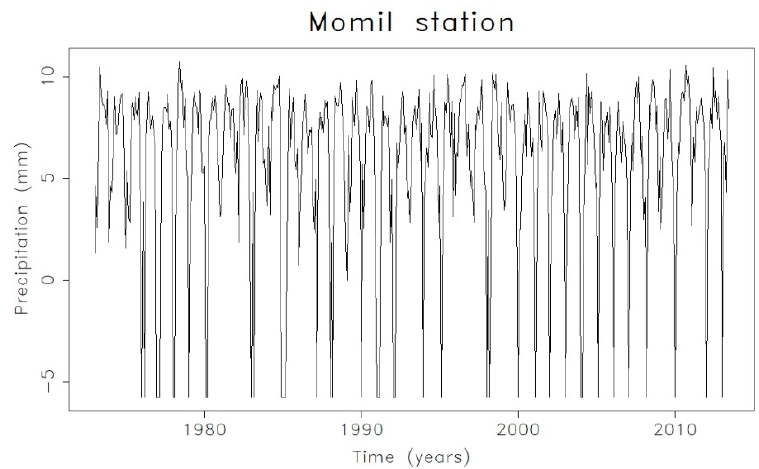
Figure 4. Calibration vector of the transformed monthly precipitation time series using Box–Cox.